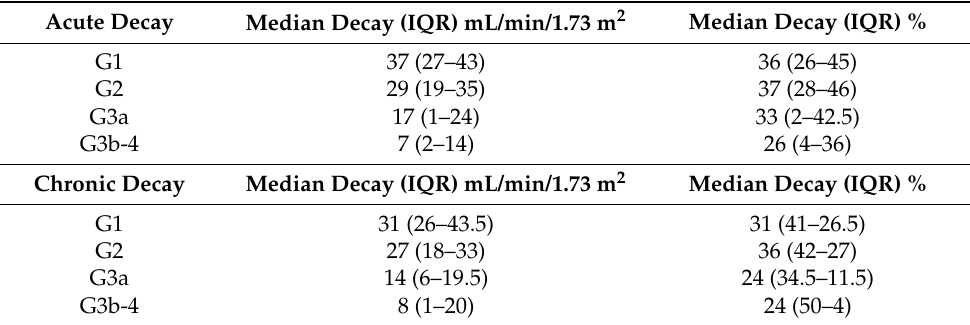
Table 4. Median eGFR decay by CKD G category.